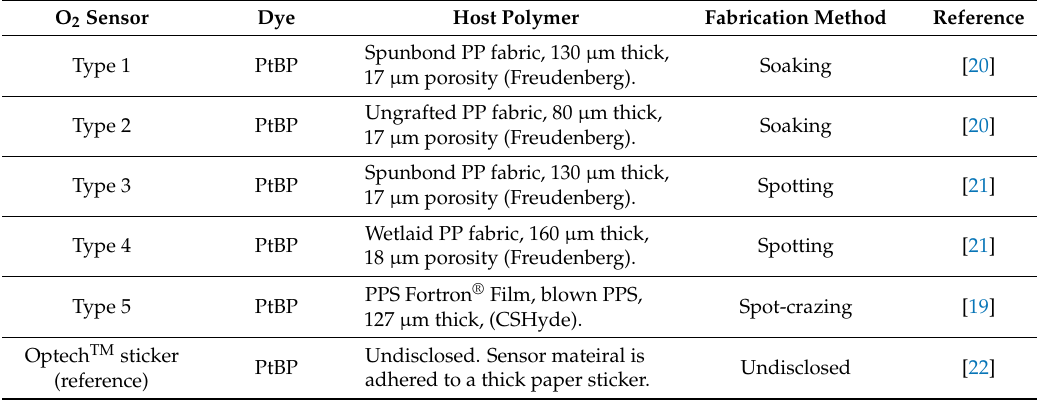
Table 1. Description of the sensor materials tested in this